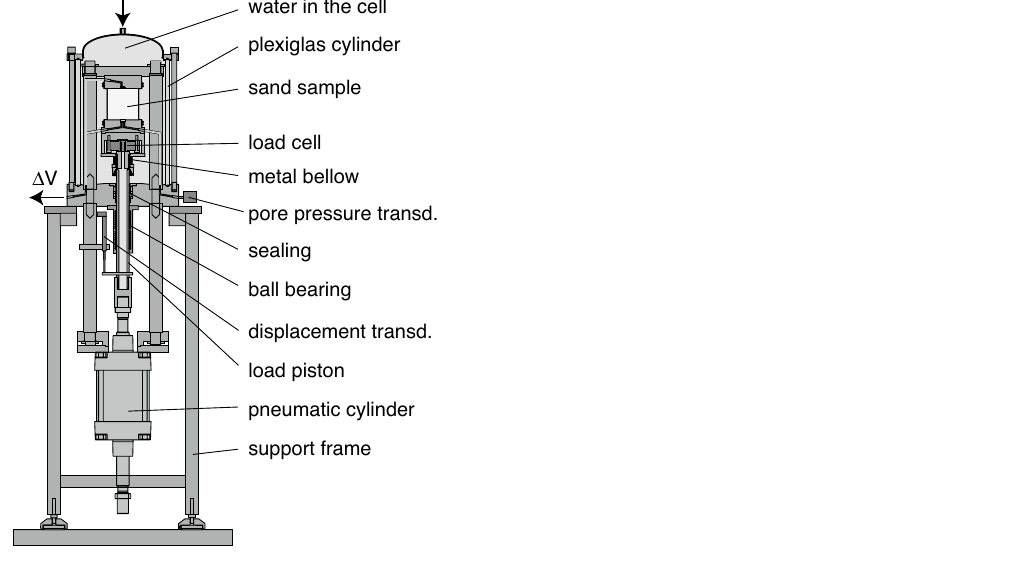
Figure 4. Scheme of triaxial device for cyclic tests 31,32 .